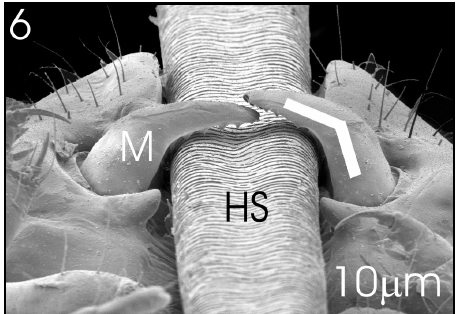
Fig. 6. The micrograph suggests that the hair shaft (HS) of the blesbuck antelope is not round in cross section but more oval in shape thus contributing to the angular (lines) adaptation of the mandibles (M).